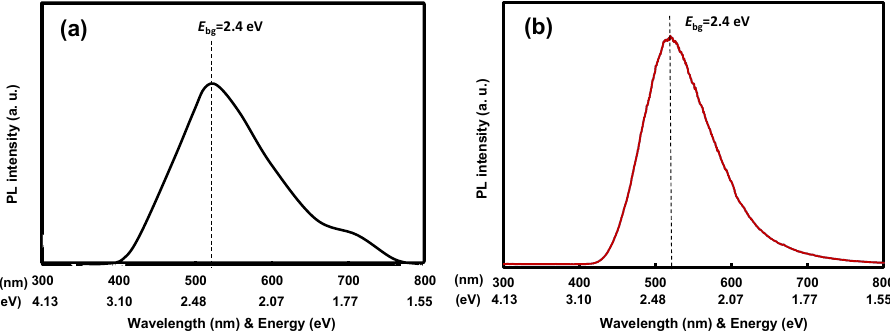
Figure 7. PL spectra of ( a ) amorphous N/TiO 2 and ( b ) anatase N/TiO 2 .